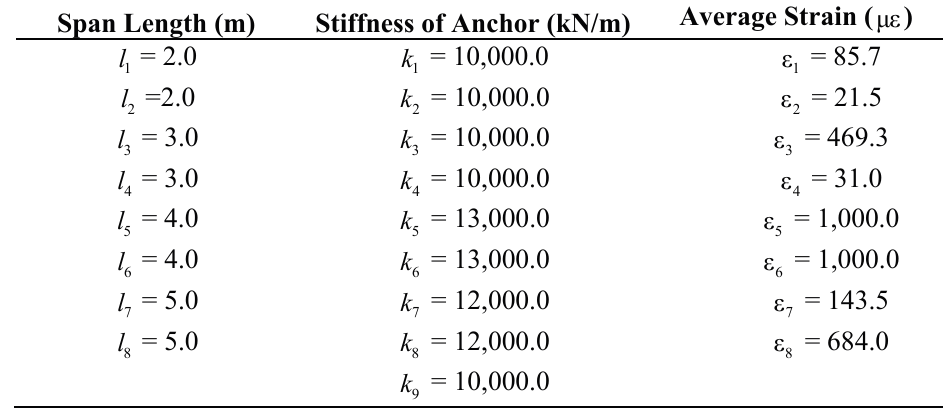
Table 2. Span length, stiffness of anchor, and average strain for an 8-span beam. Span Length (m)